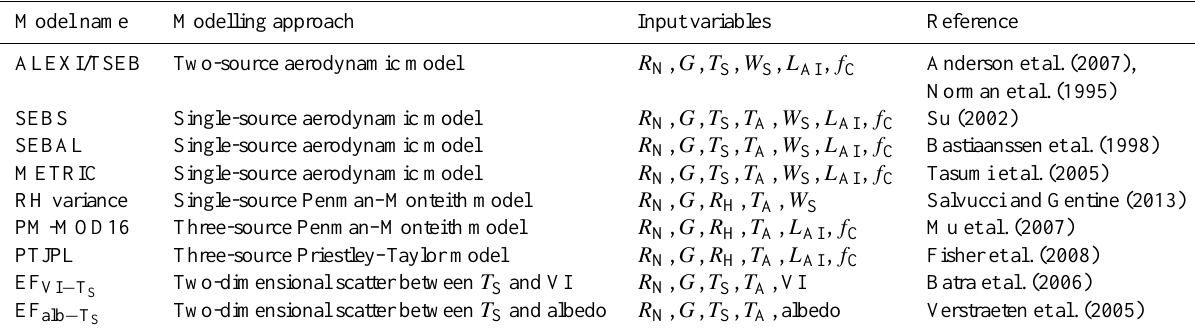
Table 1. A list of satellite-based evapotranspiration